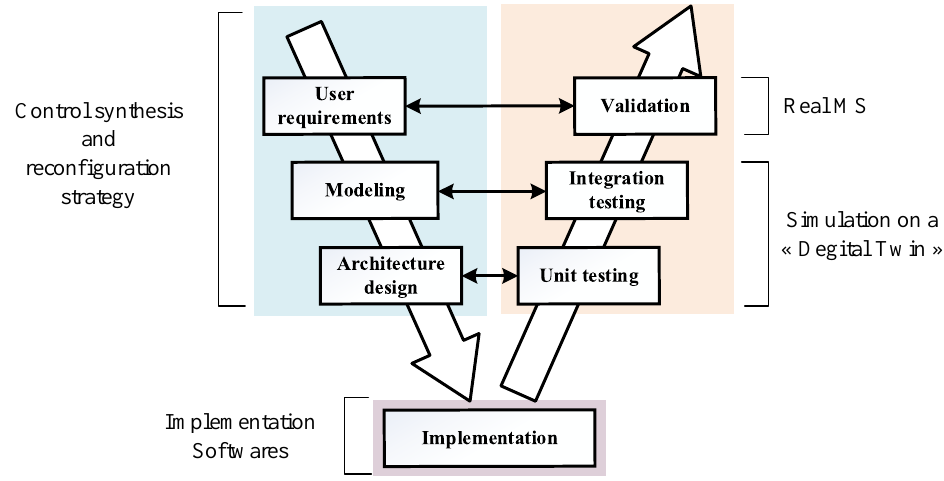
Figure 1. Design cycle of reconfigurable